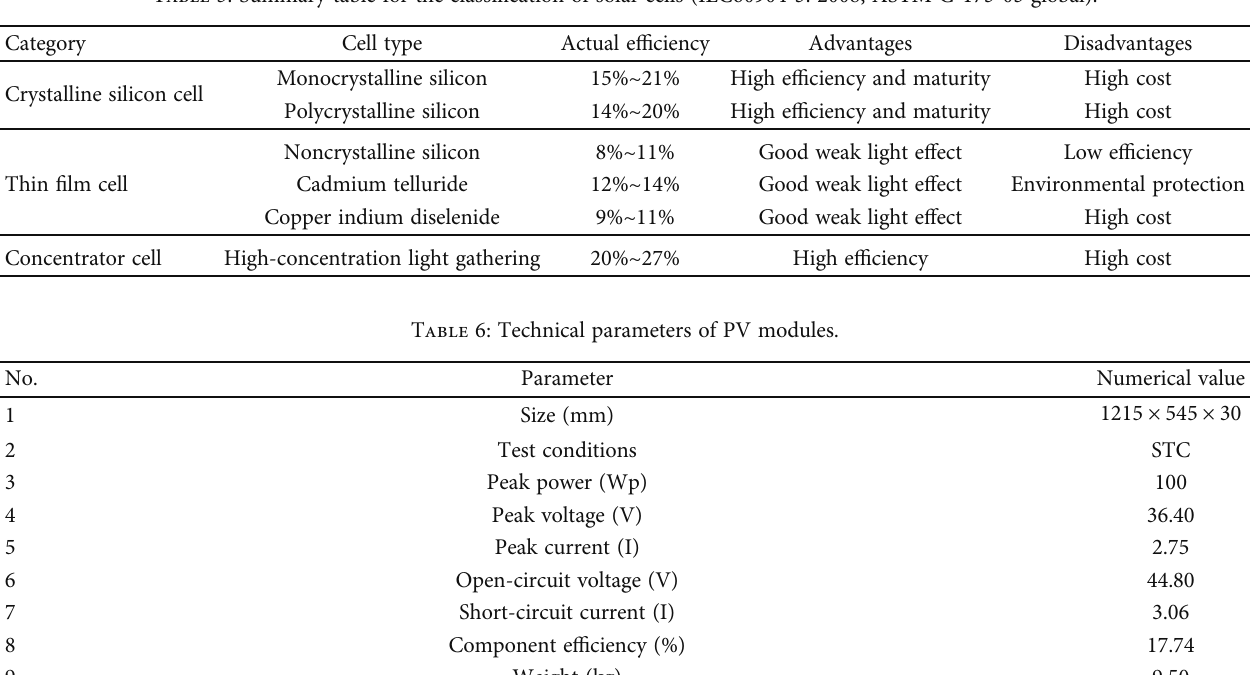
Table 5: Summary table for the classi fi cation of solar cells (IEC60904-3: 2008, ASTM G-173-03 global).